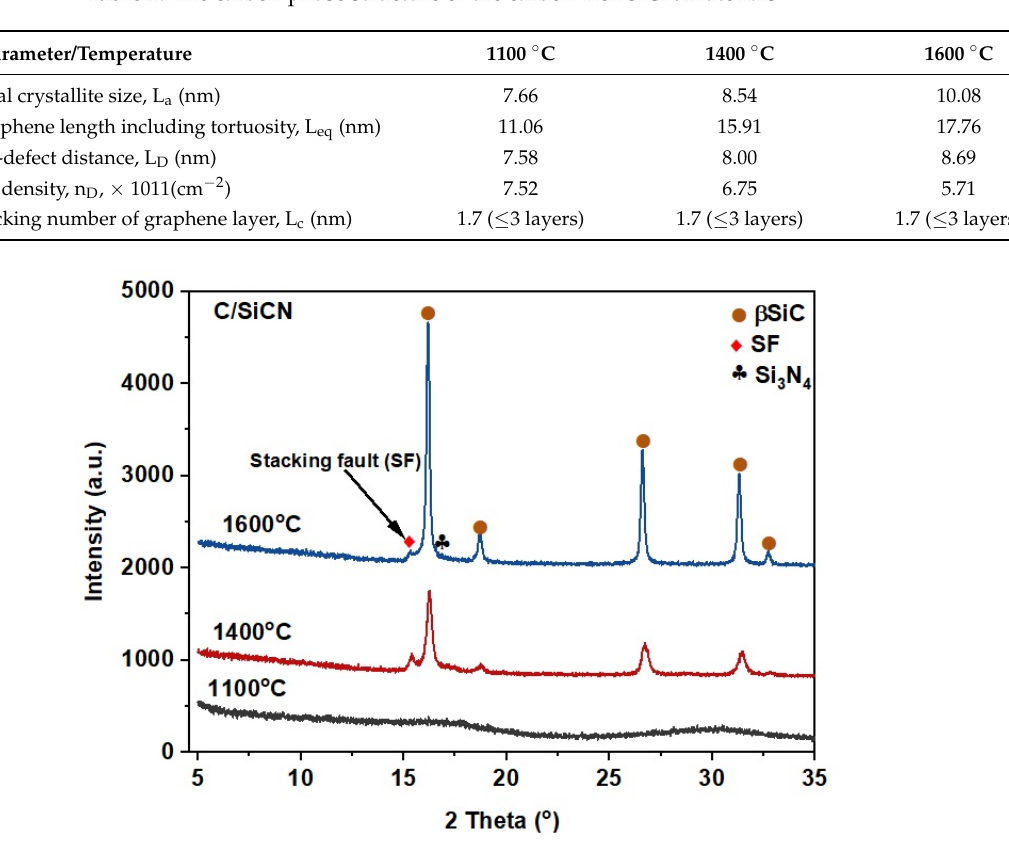
Table 1. The carbon phase structure of the carbon-rich SiCN materials.